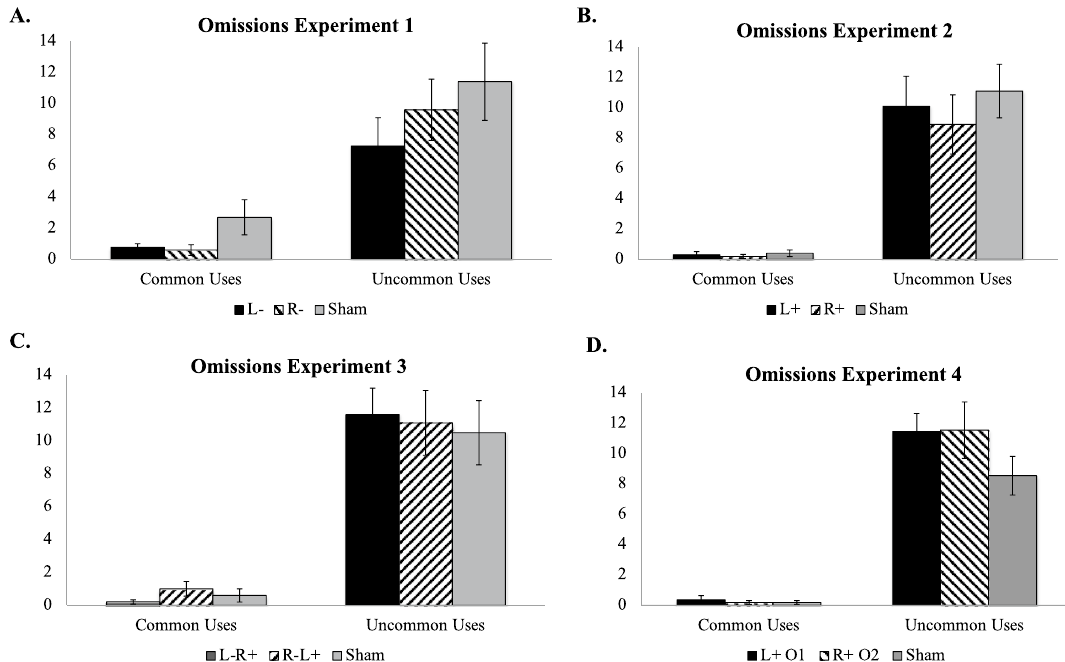
Figure 2. Average number of response omissions for Experiments 1–4 by task and stimulation condition. ( A ) Average number of response omissions for Experiment 1; ( B ) Average number of response omissions for Experiment 2; ( C ) Average number of response omissions for Experiment 3; ( D ) Average number of response omissions for Experiment 4; L- = cathodal tDCS over left ventrolateral PFC; R- = cathodal tDCS over right ventrolateral PFC. L + = anodal tDCS over left ventrolateral PFC; R + = anodal tDCS over right ventrolateral PFC. L-R + = cathodal tDCS over left ventrolateral PFC with concurrent anodal tDCS over right ventrolateral PFC; R-L + = cathodal tDCS over right ventrolateral PFC with concurrent anodal tDCS over left ventrolateral PFC. L + O1 = anodal tDCS over left occipitotemporal cortex; R + O2 = anodal tDCS over right occipitotemporal